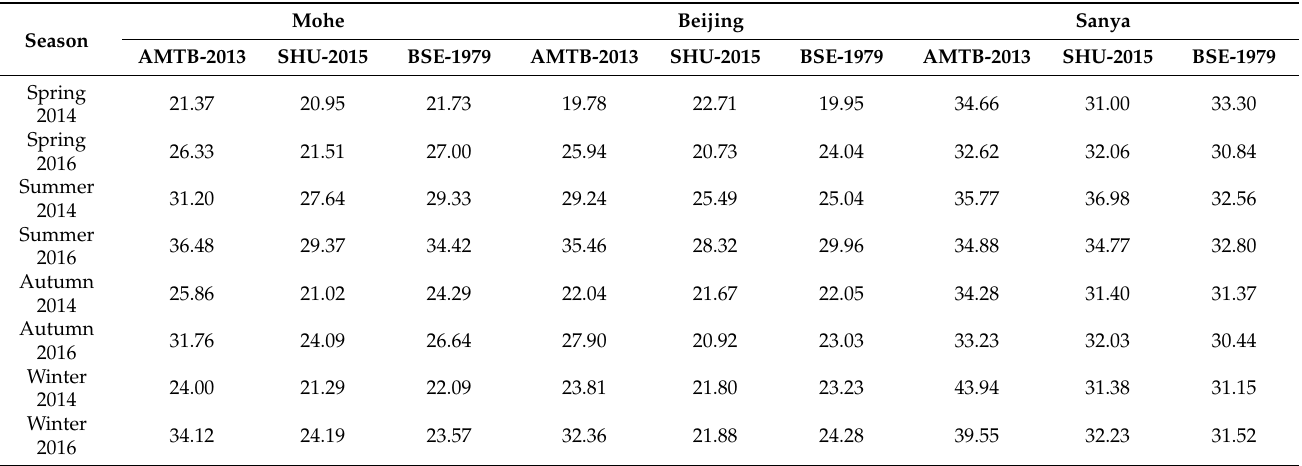
Table 5. Daily average RMS values of IRI-2016 AMTB-2013, SHU-2015 and BSE-1979 predicted hmF2 from the ionosonde hmF2 in the four different seasons for the years 2014 and 2016 at Mohe, Beijing and Sanya over China (unit: km).